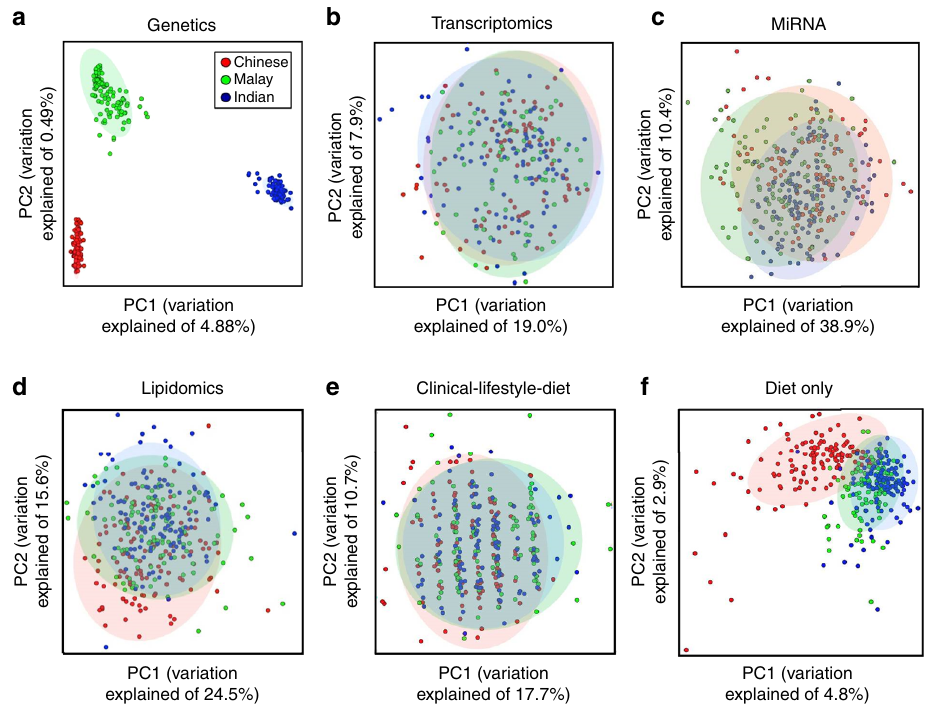
Fig. 1 PCAs of omics and clinical/lifestyle/diet data. Biplots are shown for fi ve distinct PCAs using the respective fi rst two axes of variations from each PCA. The fi ve PCAs correspond to the analysis of: a 101,099 autosomal SNPs pseudo-randomly chosen to minimize linkage disequilibrium between the SNPs; b 21,649 gene transcript probesets; c 274 miRNAs; d 282 lipid species; e a set of 284 clinical, lifestyle, and dietary variables; and f only the 199 dietary variables. Each circle represents an individual from the iOmics and is assigned a color corresponding to the self-reported ethnicity of the subject, according to the color legend on the top right panel in